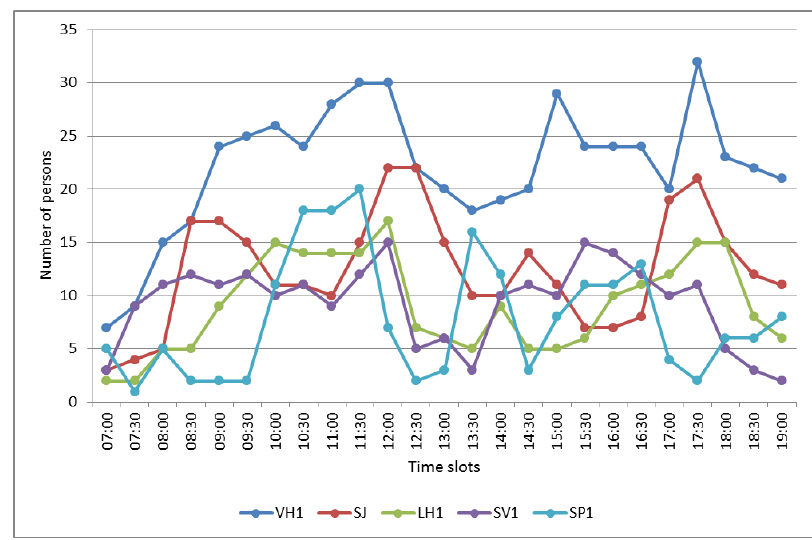
Figure 4. Overall presence in the living rooms during the observation day.